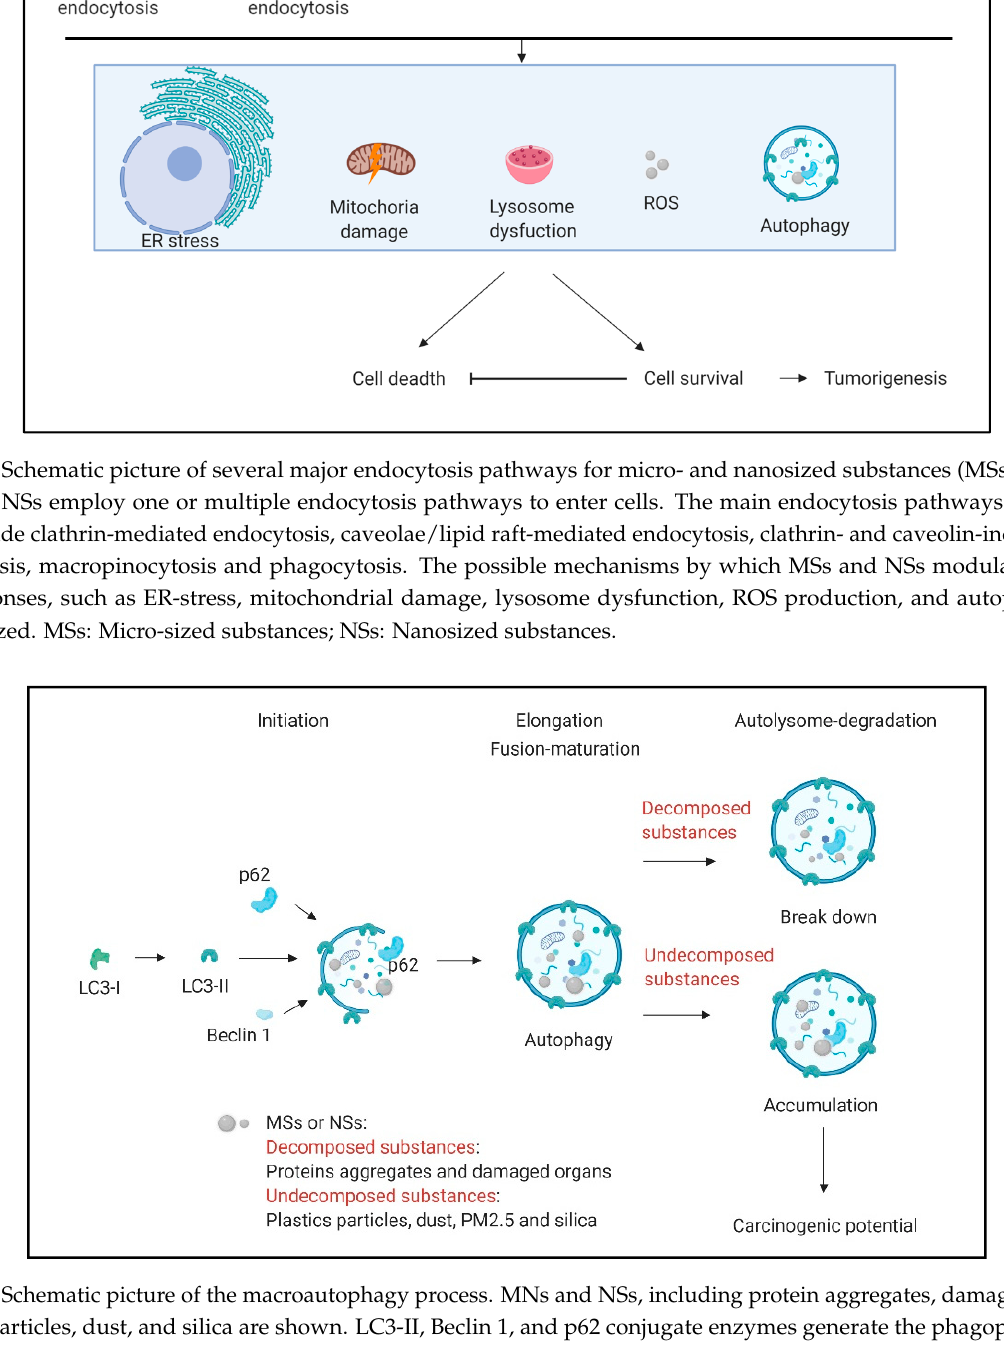
Figure 2. Schematic picture of the macroautophagy process. MNs and NSs, including protein aggregates, damaged organs, plastics particles, dust, and silica are shown. LC3-II, Beclin 1, and p62 conjugate enzymes generate the phagophore form and then the surrounding MNs and NSs during the elongation stage. At the end of the elongation stage, the membrane is sealed to form a double-membrane vesicle, called the autophagosome, which contains degraded cellular enzymes. The autophagosome fuses with a lysosome, forming an autolysosome in which lysosomal enzymes degrade the cargo and release the degraded products into the cytoplasm. Undecomposed MSs and NSs, such as dust and silica, have carcinogenic potential.